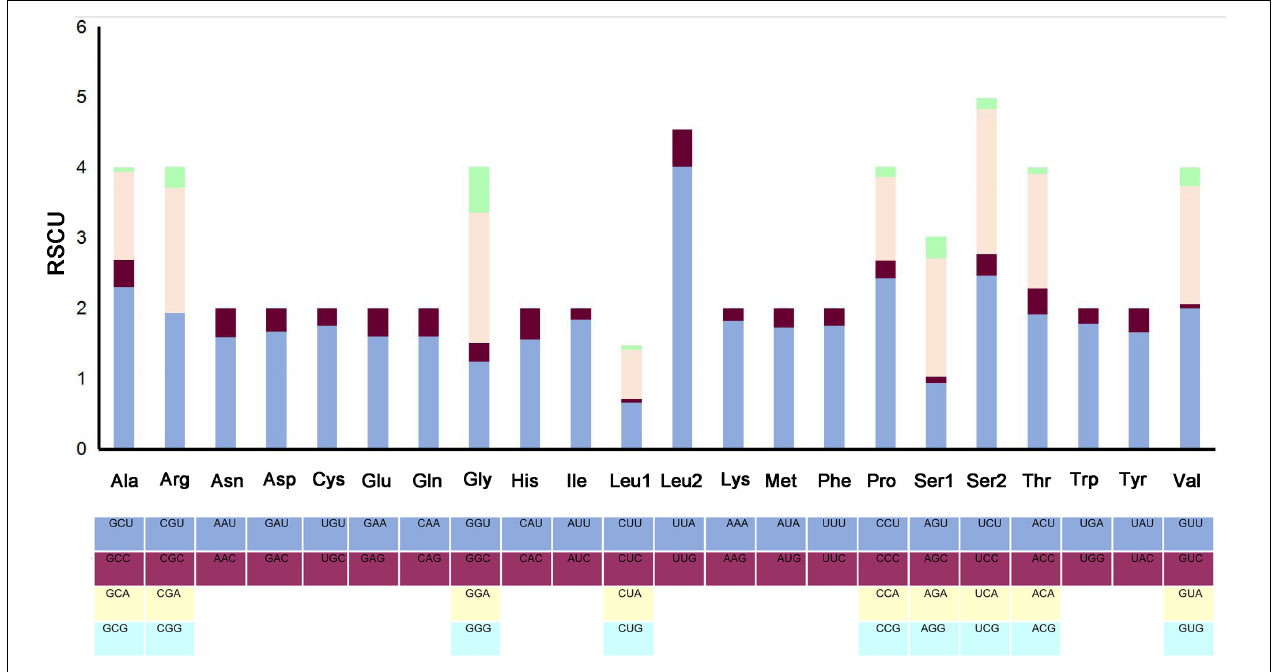
FIGURE 2 | The RSCU in the P . bidens